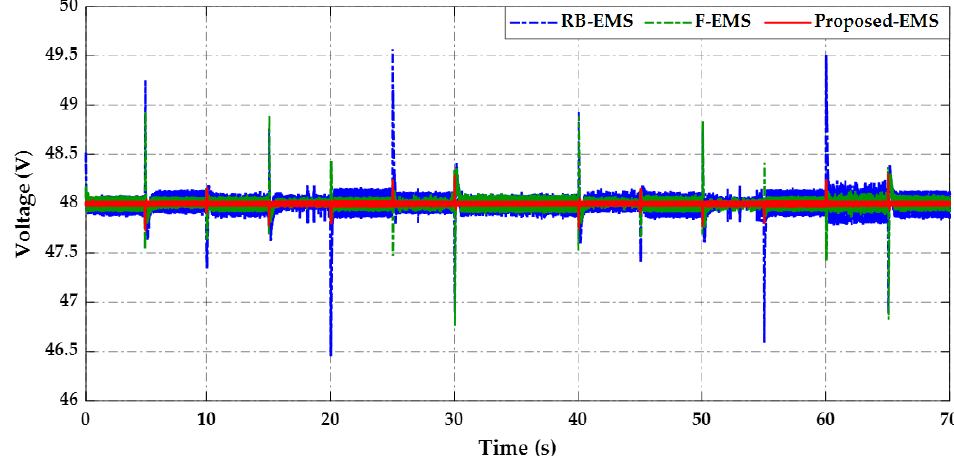
Figure 20. The comparison of the DC bus voltage.